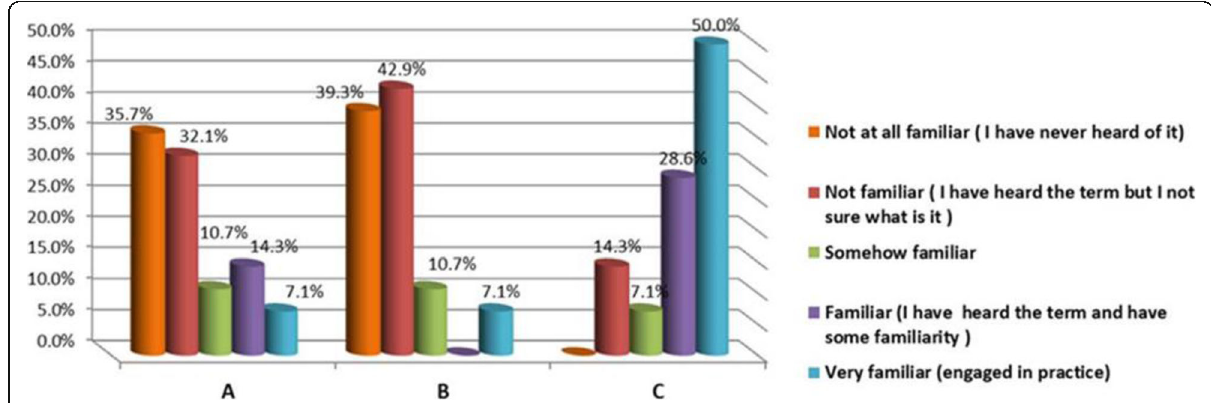
Fig. 2 Pre-education familiarity of the respondents ’ physicians and pharmacists with terms. a . Antimicrobial stewardship, b . Antibiogram, c . Antibiotics